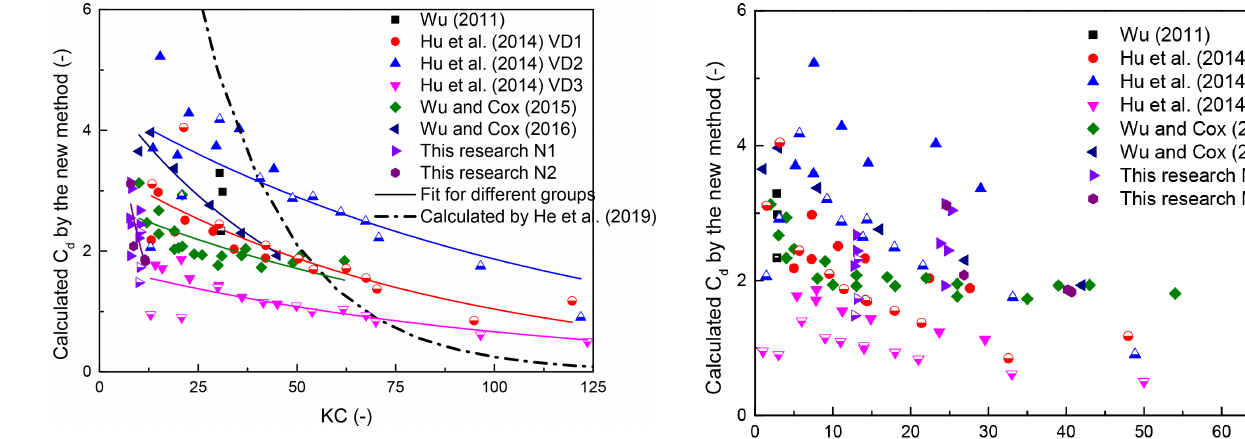
Figure 8. Relation between KC and the calculated C D by the new method. Details are the same as Fig. 7.